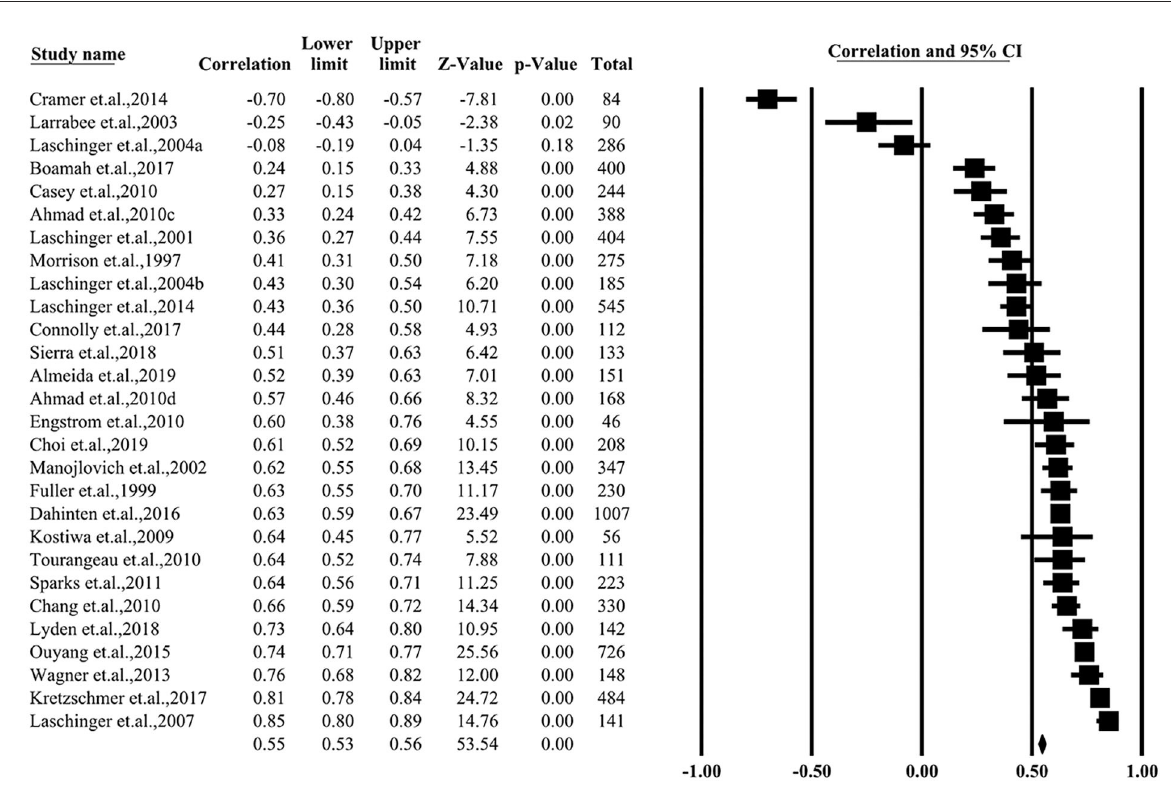
FIGURE2 Summarized overall